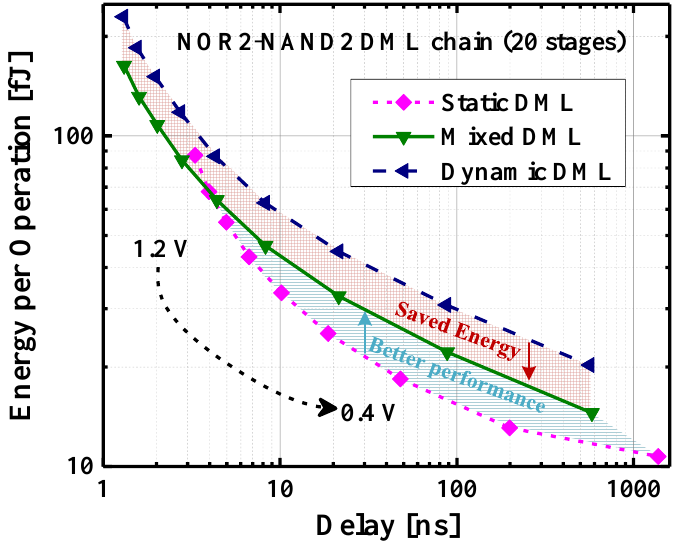
Figure 2. Energy-delay trade-offs of DML modes. Simulation data considers a 20-stage NAND2- NOR2 DML